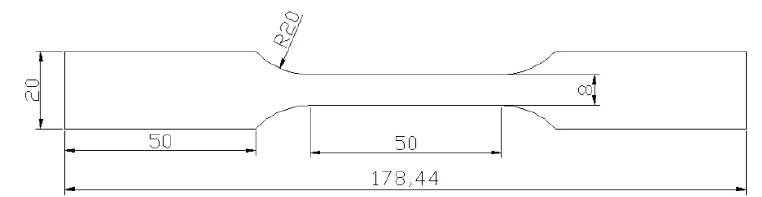
Figure 2. Quasi-static tensile specimens with thickness 1.5mm (unit=mm).